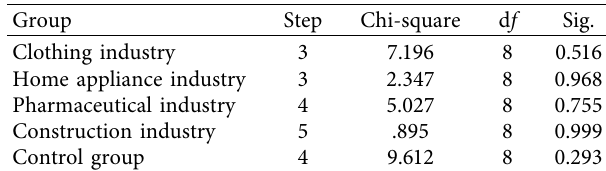
Table 12: Hosmer Lemeshow